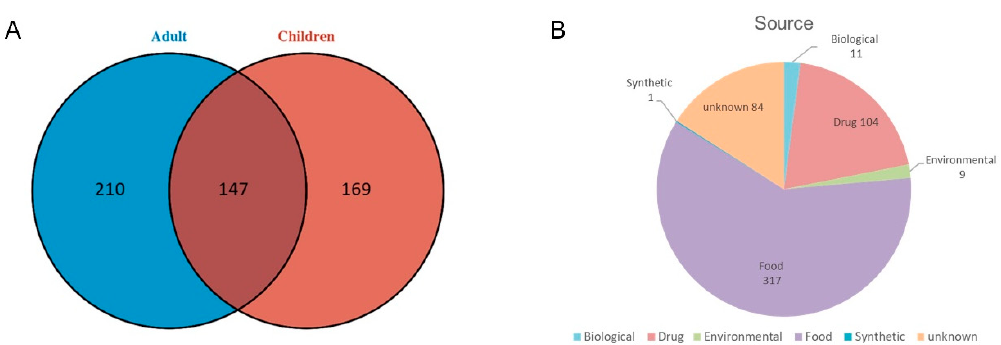
Figure 6. Detection of exogenous metabolites. ( A ) The overlap among the exogenous metabolites identified in children and adults. ( B ) The source of exogenous metabolites.